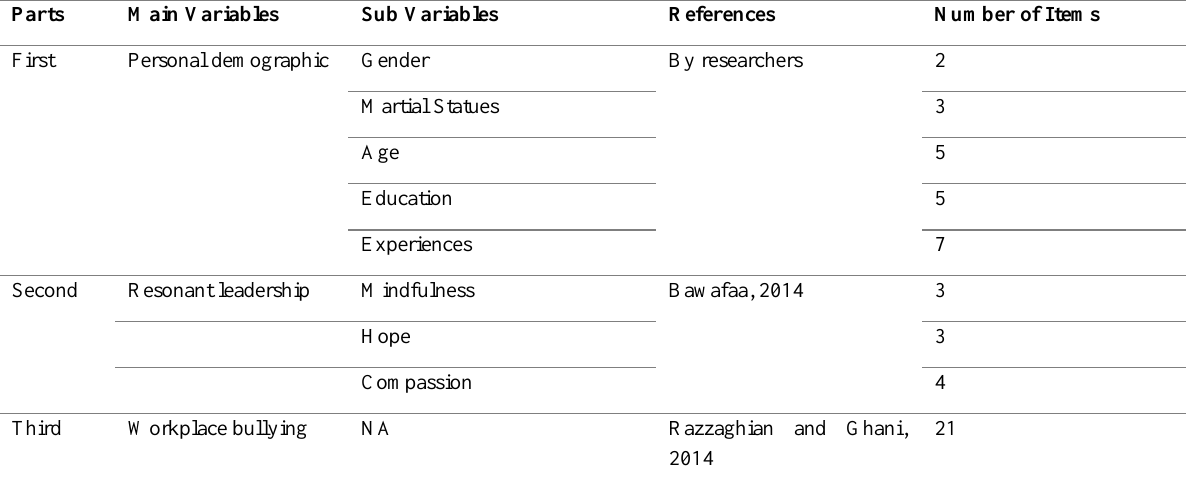
Table 3: Design of Questionnaires and References